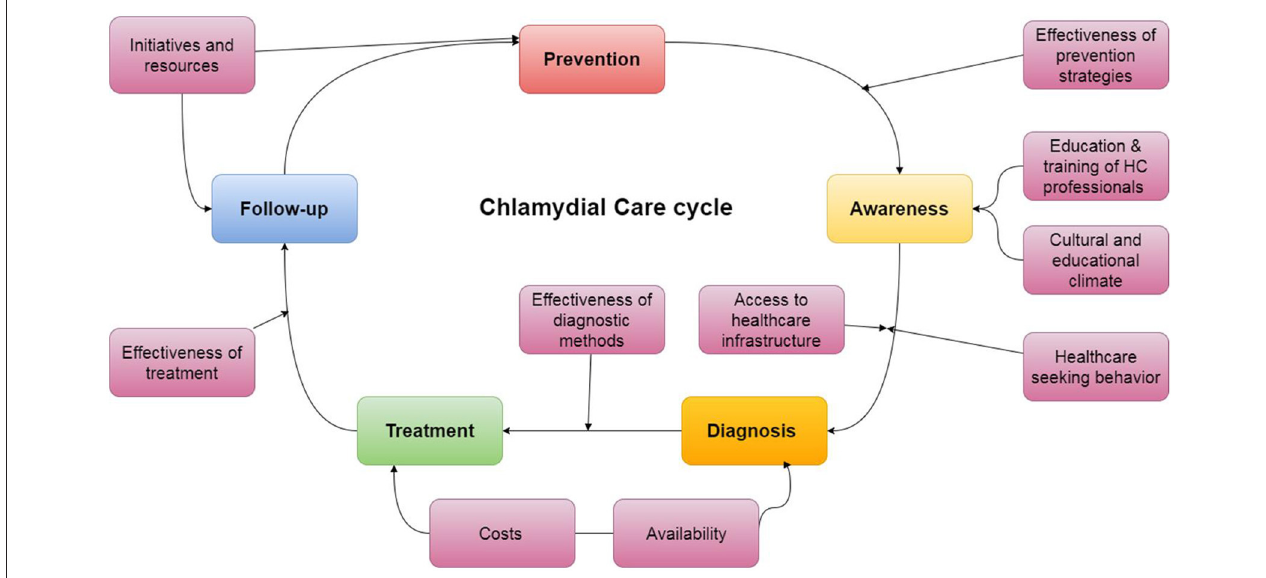
FIGURE 3 | Proposed integrated model to improve Chlamydia trachomatis management and control in India.